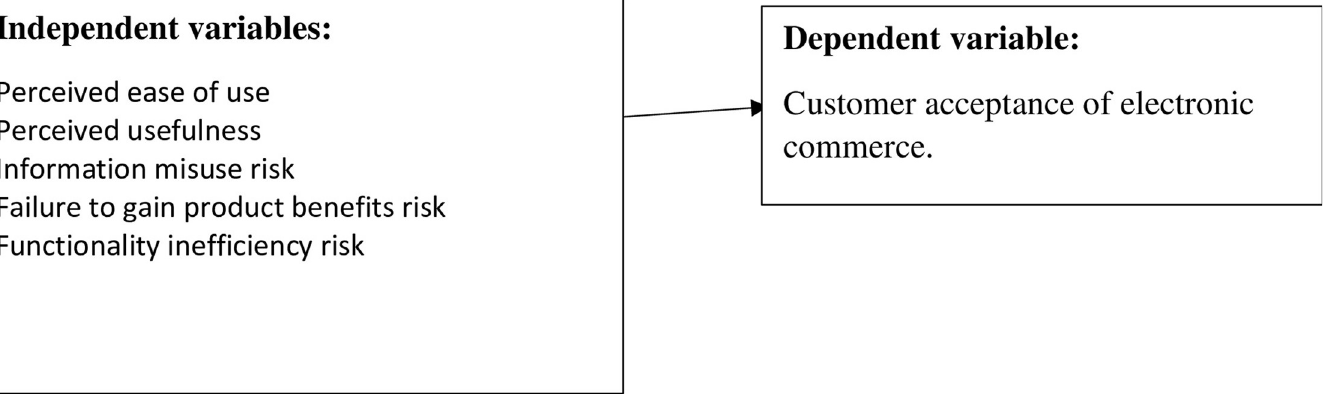
Fig 1. Relationship between the